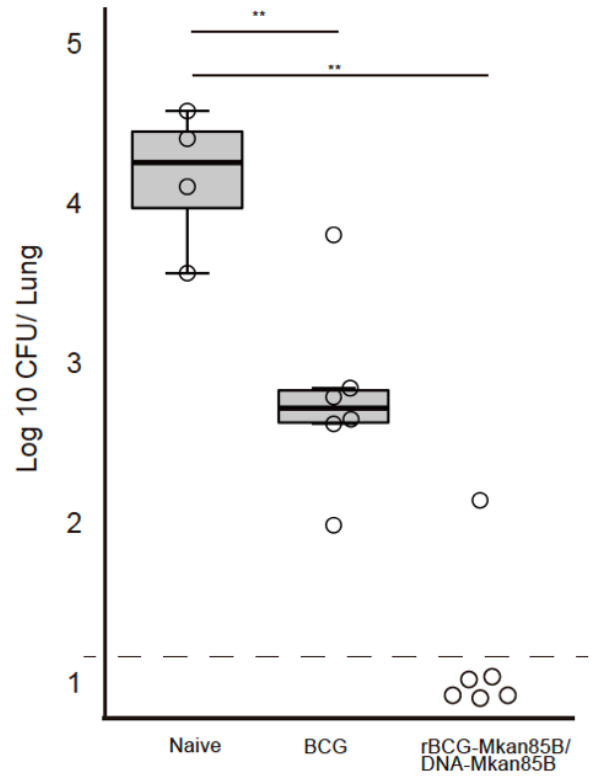
Figure 3. rBCG-Mkan85B/DNA-Mkan85B vaccination protects against M. kansasii infection. The CB6F1 mice were either left unimmunized or immunized with BCG or rBCG-Mkan85B/DNA- Mkan85B and then challenged with a virulent M. kansasii strain for another 6 weeks. The immun- ization schedule is shown in Figure S1B. The mice were sacrificed at 6 weeks after M. kansasii infec- tion. The number of M. kansasii in individual mouse lungs was analyzed using the colony assay method. The data represent two independent experiments with five to six mice per group. The de- tection limit for bacilli in the tissue homogenate was 15 CFU. The error bars represent the SD. ** p < 0.01.